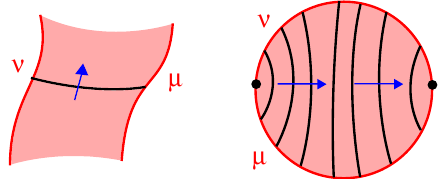
Figure 1 . Left: wavefunction ψ R,νµ ( g ) in a mixed parabolic basis as a two-boundary state. Right: two-boundary slicing of the